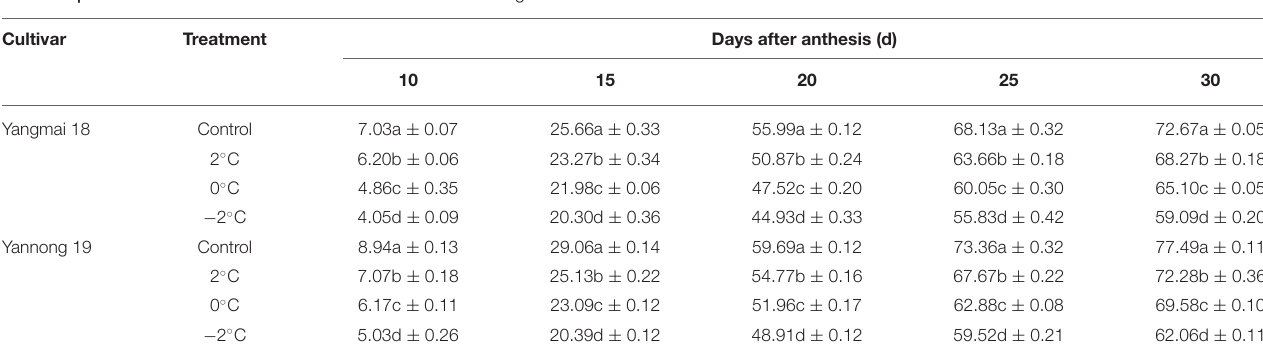
TABLE 1 | Effects of different treatments on starch content in wheat grains.